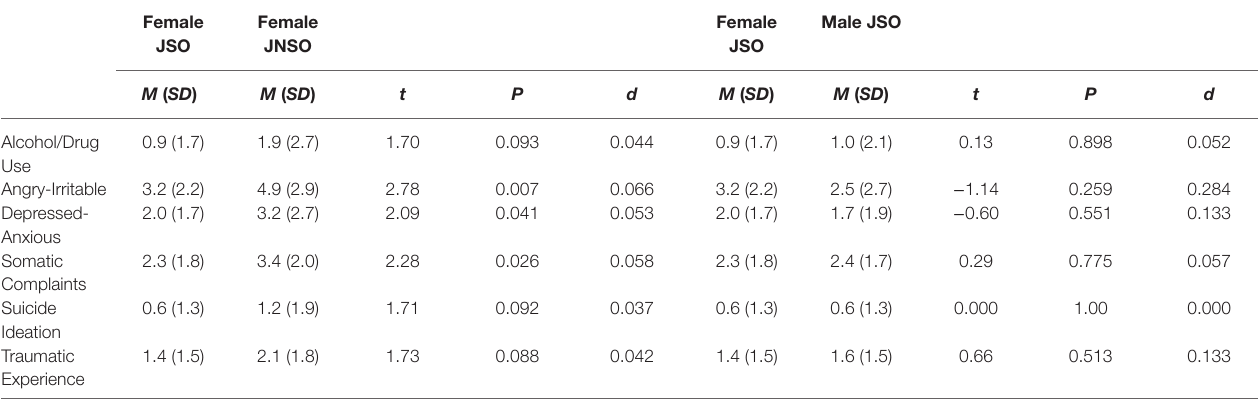
TABLE 3 | Comparison female JSOs, female NJSOs, and male JSOs. Female Female JSO